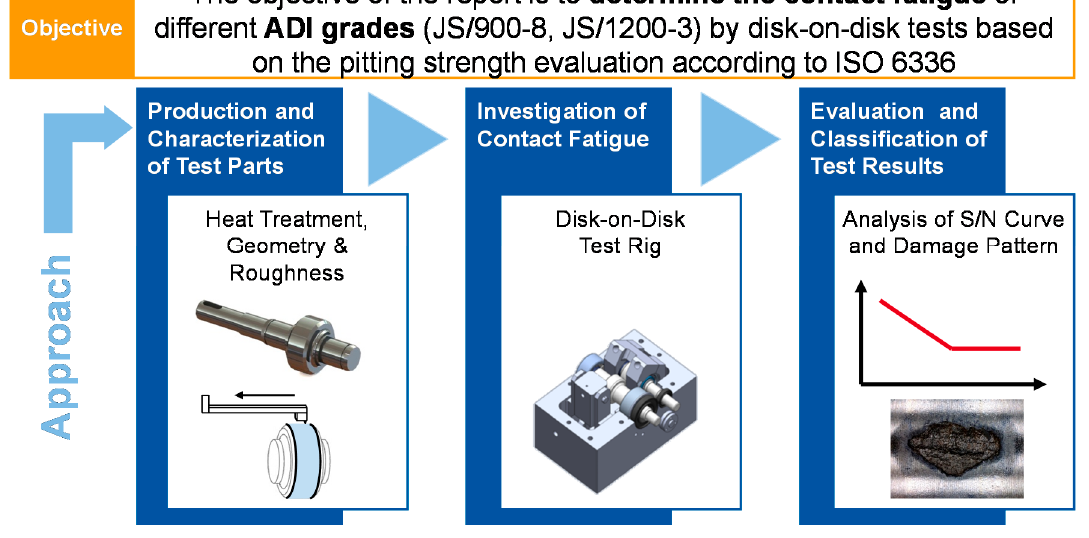
Figure 2. Objective and Approach.